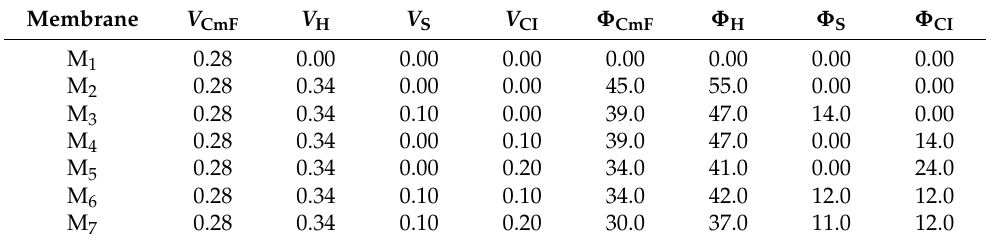
Table 1. Composition of membranes M i , with i = 1, . . . ,7. V CmF , V H , V S , and V CI are the volumes (in cm 3 ) of the cotton microfibers, honey, silver microparticles, and CI microparticles, respectively, and Φ Φ Φ Φ H , CmF , S , and CI are their respective volume fractions (in vol .%). Membrane